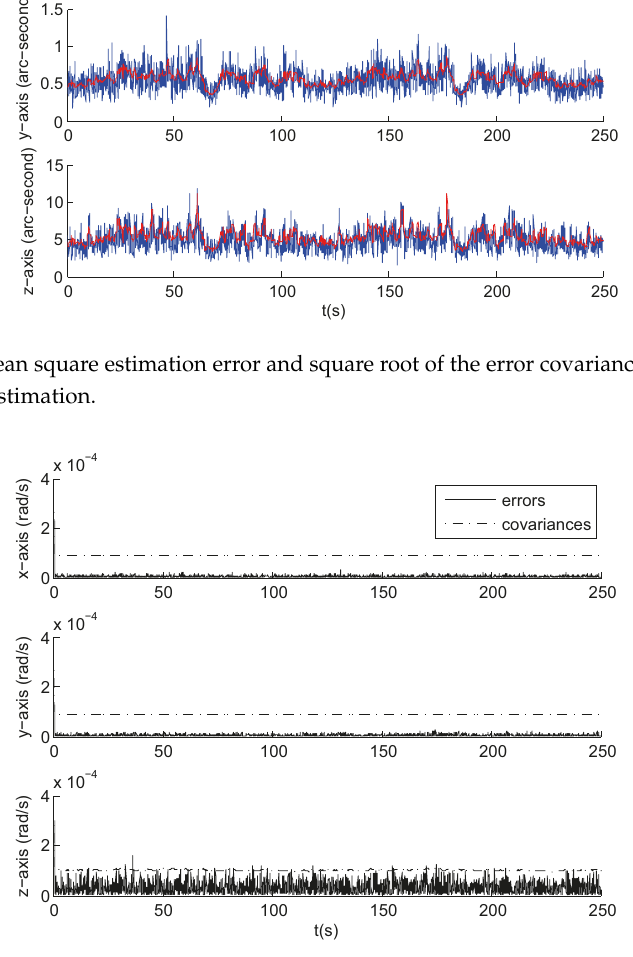
Figure 12. Root mean square estimation error and square root of the error covariance from the Kalman filter for angular velocity estimation.